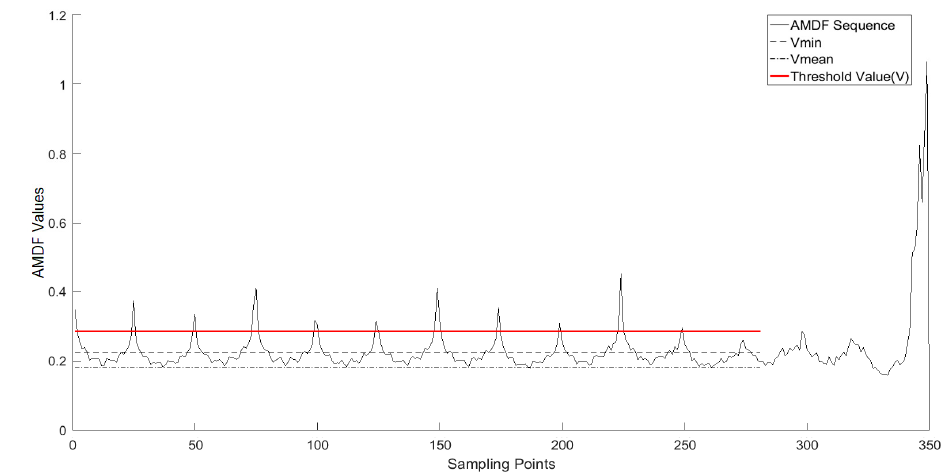
Figure 7. Simulation results of the peak extraction algorithm.